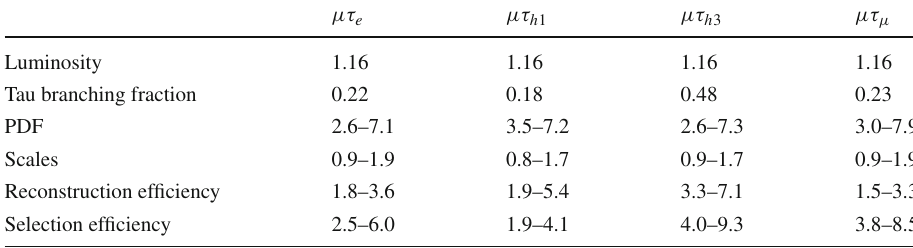
Fig. 1 Invariant-mass distributions for the μ ± τ ∓ candidates for the four decay channels (from top to bottom: μτ e , μτ h 1 , μτ h 3 , μτ μ ) and the three selections (from left to right: L-selection, C-selection, H- selection). The distribution of candidates observed (black points) is